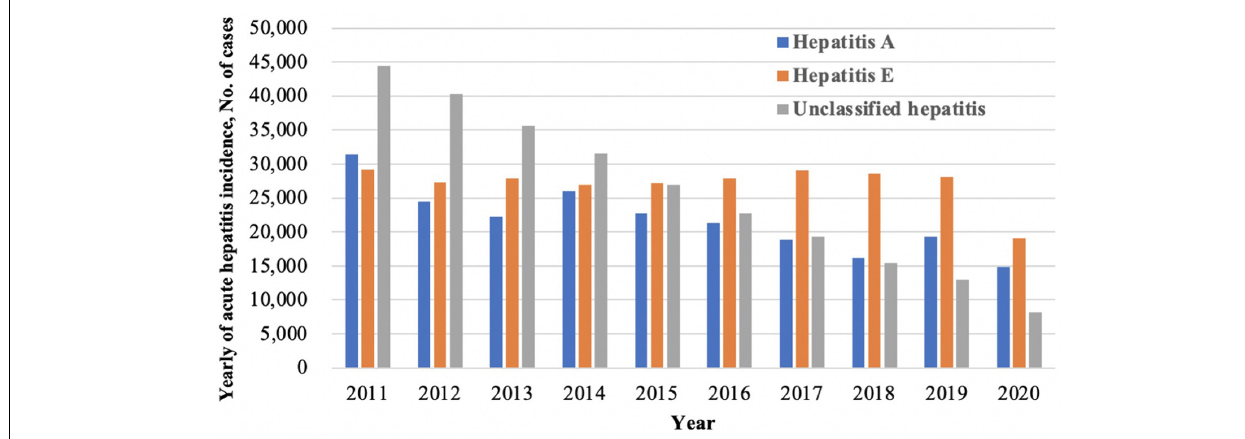
FIGURE 1 | Trends in acute hepatitis cases, China, 2011–2020.